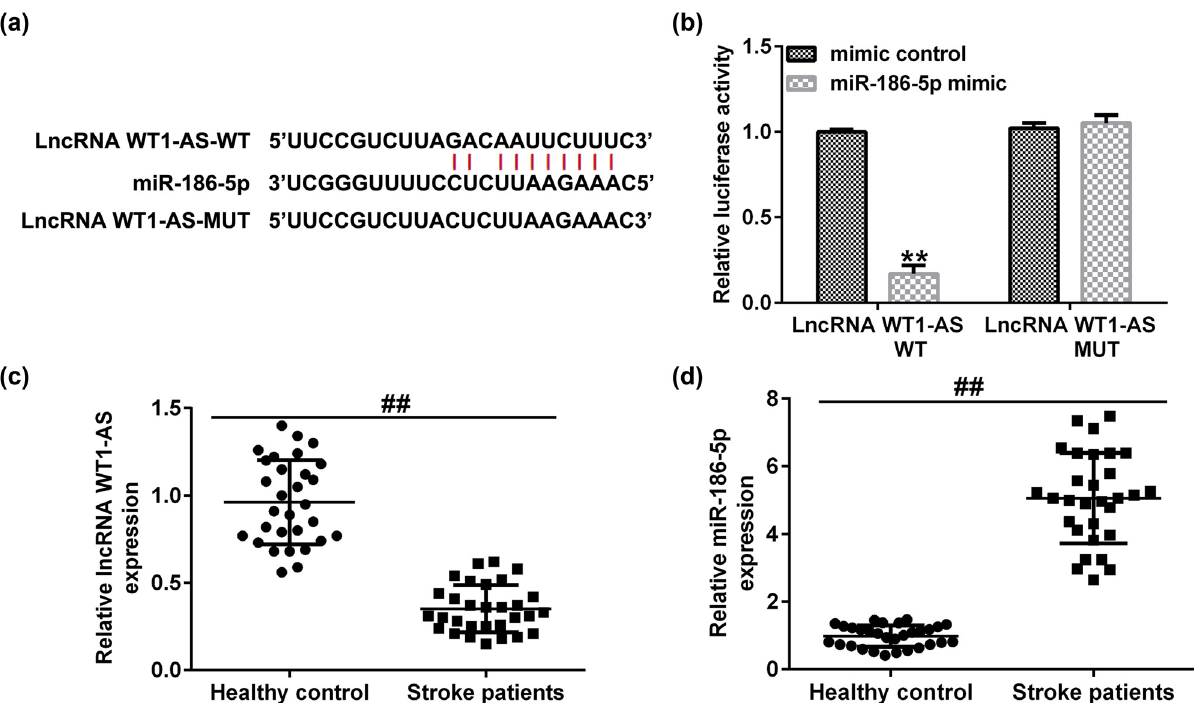
Figure 1: Expression levels of lncRNA WT1 - AS and miR - 186 - 5p in patients with ischemic stroke. ( a ) Interaction between miR - 186 - 5p and WT1 - AS 3 ′ - UTR was predicted using the Starbase prediction software. ( b ) Dual luciferase reporter gene assay was used to verify the interaction between WT1 - AS and miR - 186 - 5p in 293T cells co - transfected with miR - 186 - 5p mimics and WT or MUT WT1 - AS 3 ′ - UTR reporter plasmids. ( c and d ) Expression levels of WT1 - AS and miR - 186 - 5p in blood samples of patients with ischemic stroke and healthy individuals. ** P < 0.01 vs control mimics group; ## P < 0.01 vs healthy control group. GraphPad Prism 6.0 software ( GraphPad Software, Inc. ) was used for creation of the fi